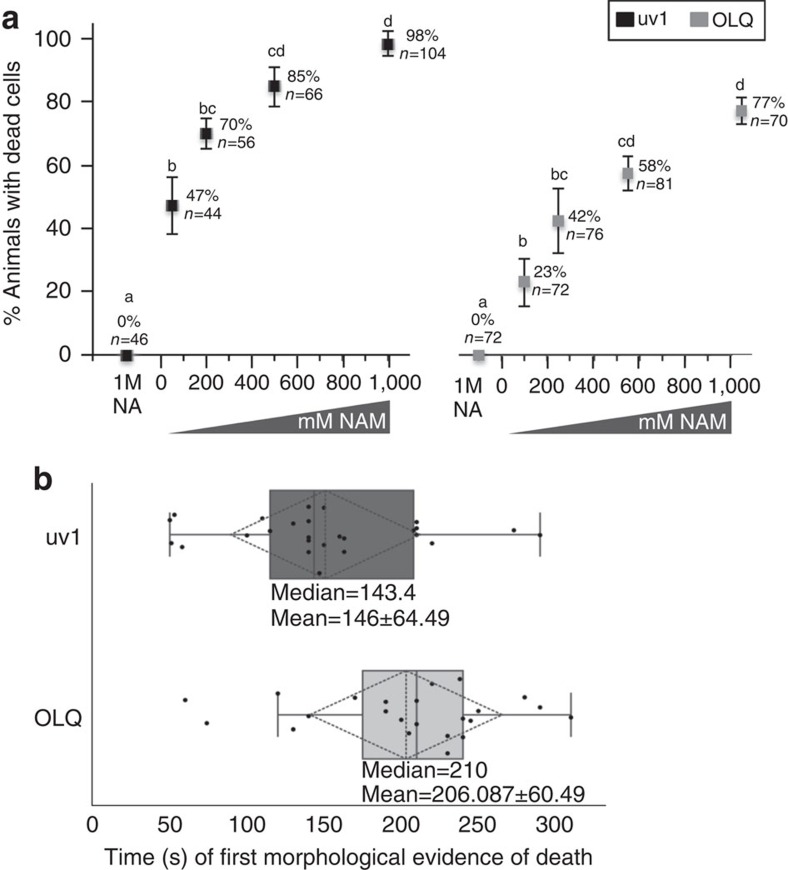
Acute application of NAM results in rapid death of uv1 and OLQ cells.(a) 50, 200, 500 or 1,000 mM NAM or 1,000 mM NA (control) was added to individual animals and the percentage of animals with dying uv1 (black markers) or OLQ cells (grey markers) was quantified. Actual percentages and total number of animals examined (n) are indicated for each data point. Values represent the average from at least three supplementation experiments and error bars are standard deviations. For statistical analysis, P values for all pairwise comparisons were calculated using Fisher's exact test with a Bonferroni correction considering 10 total pair-wise comparisons for each experiment. Data points marked with distinct annotations (a–d) within each experiment indicate statistical differences with a Bonferroni adjusted P<0.001. (b) Cell death in response to acute NAM treatment is rapid. Each dot represents an individual animal and the position on the X-axis represents the time after NAM addition when the first evidence of cell death, nuclear disintegration, was evident. Boxes show the upper and lower quartile values, solid and dashed vertical lines indicate the median and mean of the population distribution, respectively. The dotted rhombus indicates one standard deviation, and error bars indicate the maximum and minimum of the population distribution. Two of the data points for OLQ were statistical outliers and not included in the statistical analysis.